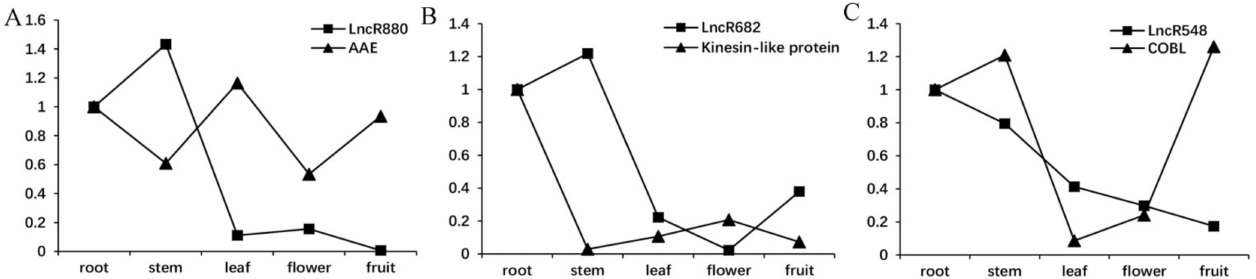
Figure 5. QRT-PCR validation of expression profiles of lncRNA/structural gene pairs of lncR880/AAE ( A ), lncR682/kinesin- like protein ( B ) and lncR578/COBL ( C ). The average expression profile of every gene in the root was chosen as a control and set to